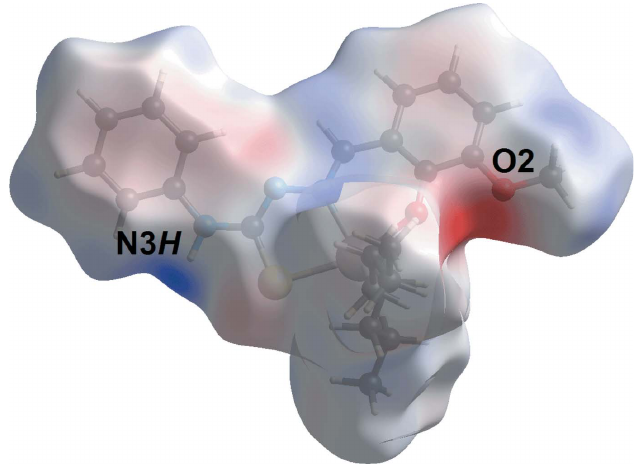
Figure 4 A view of the Hirshfeld surface mapped over the calculated electrostatic